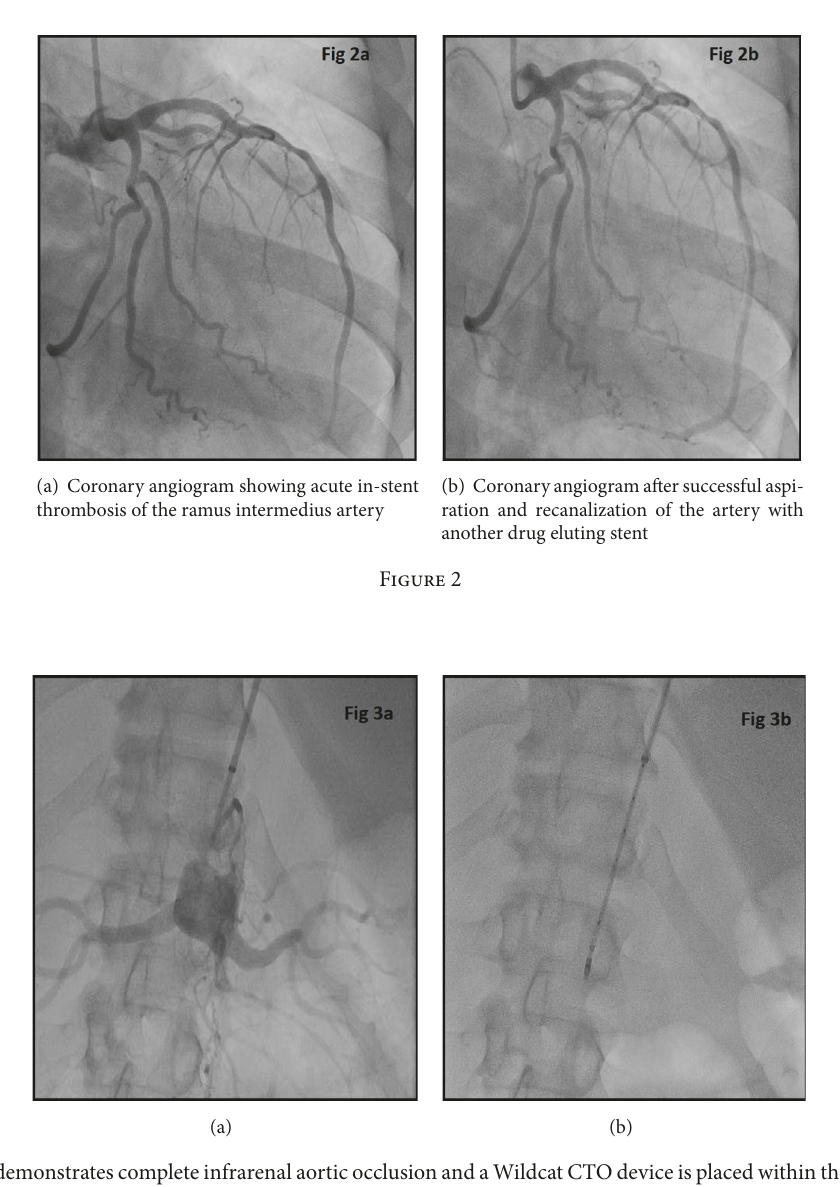
Figure 3: Angiogram demonstrates complete infrarenal aortic occlusion and a Wildcat CTO device is placed within the occlusion. A complex catheterization was performed using the Wildcat looped wire